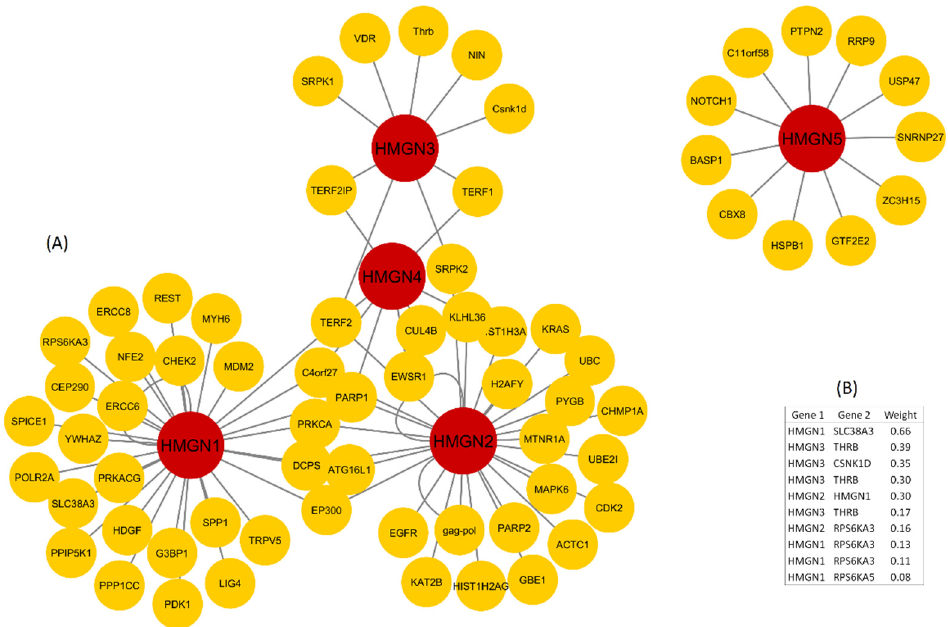
Figure 1. Protein-to-protein interaction network between the five human High-Mobility-Group Nucleosome-Binding (HMGN) proteins and several cellular human genes. ( A ) Topological structure of the network using Cytoscape program. ( B ) The statistically significant cellular genes that interact with some of one HMGN. Data were obtained from GeneMania database.